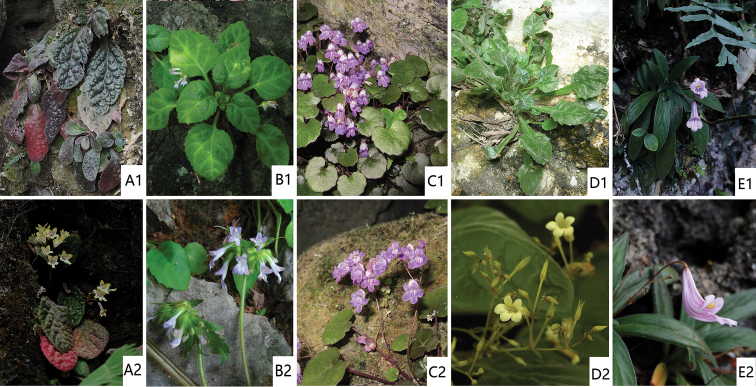
The morphologically similar congeners of the five new species of Primulina1 habit 2 flowers. AP.leprosa, the congener of P.purpureokylinBP.gongchengensis, the congener of P.persicaCP.renifolia, the congener of P.cerinaDP.repanda, the congener of P.niveolanosaEP.longgangensis, the congener of P.leiyyi. Photographed by Fang Wen, charted by Wen-Hua Xu.